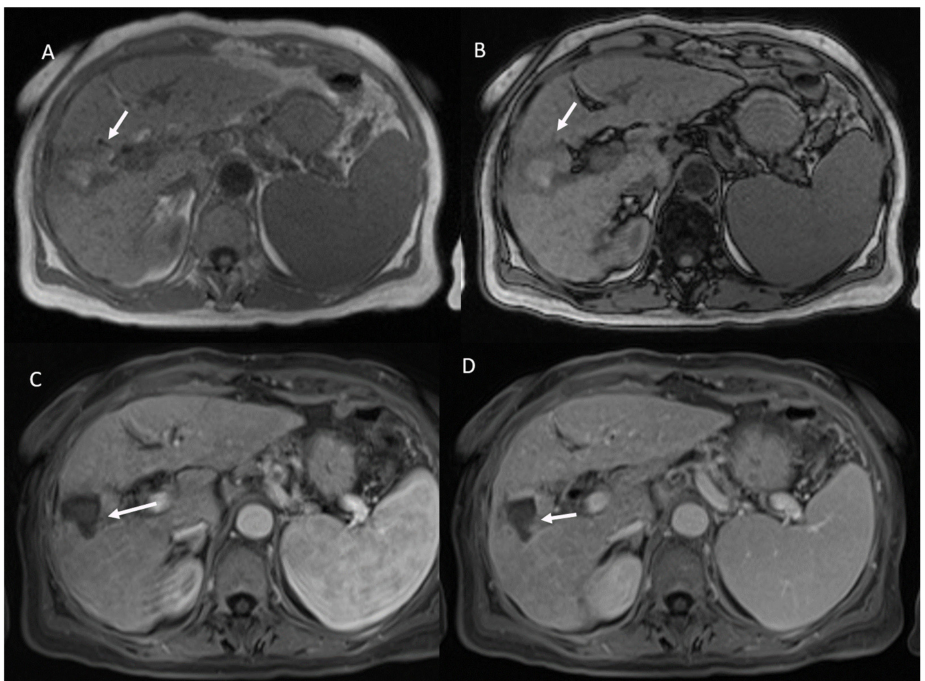
Figure 5. Non-viable treated HCC. In T1-W sequences ( A , in phase and B , out of phase) the arrow shows hyperintense SI of ablated area. During contrast study the non-viable lesion shows hypointense SI in arterial ( C ) and portal ( D ) phase.